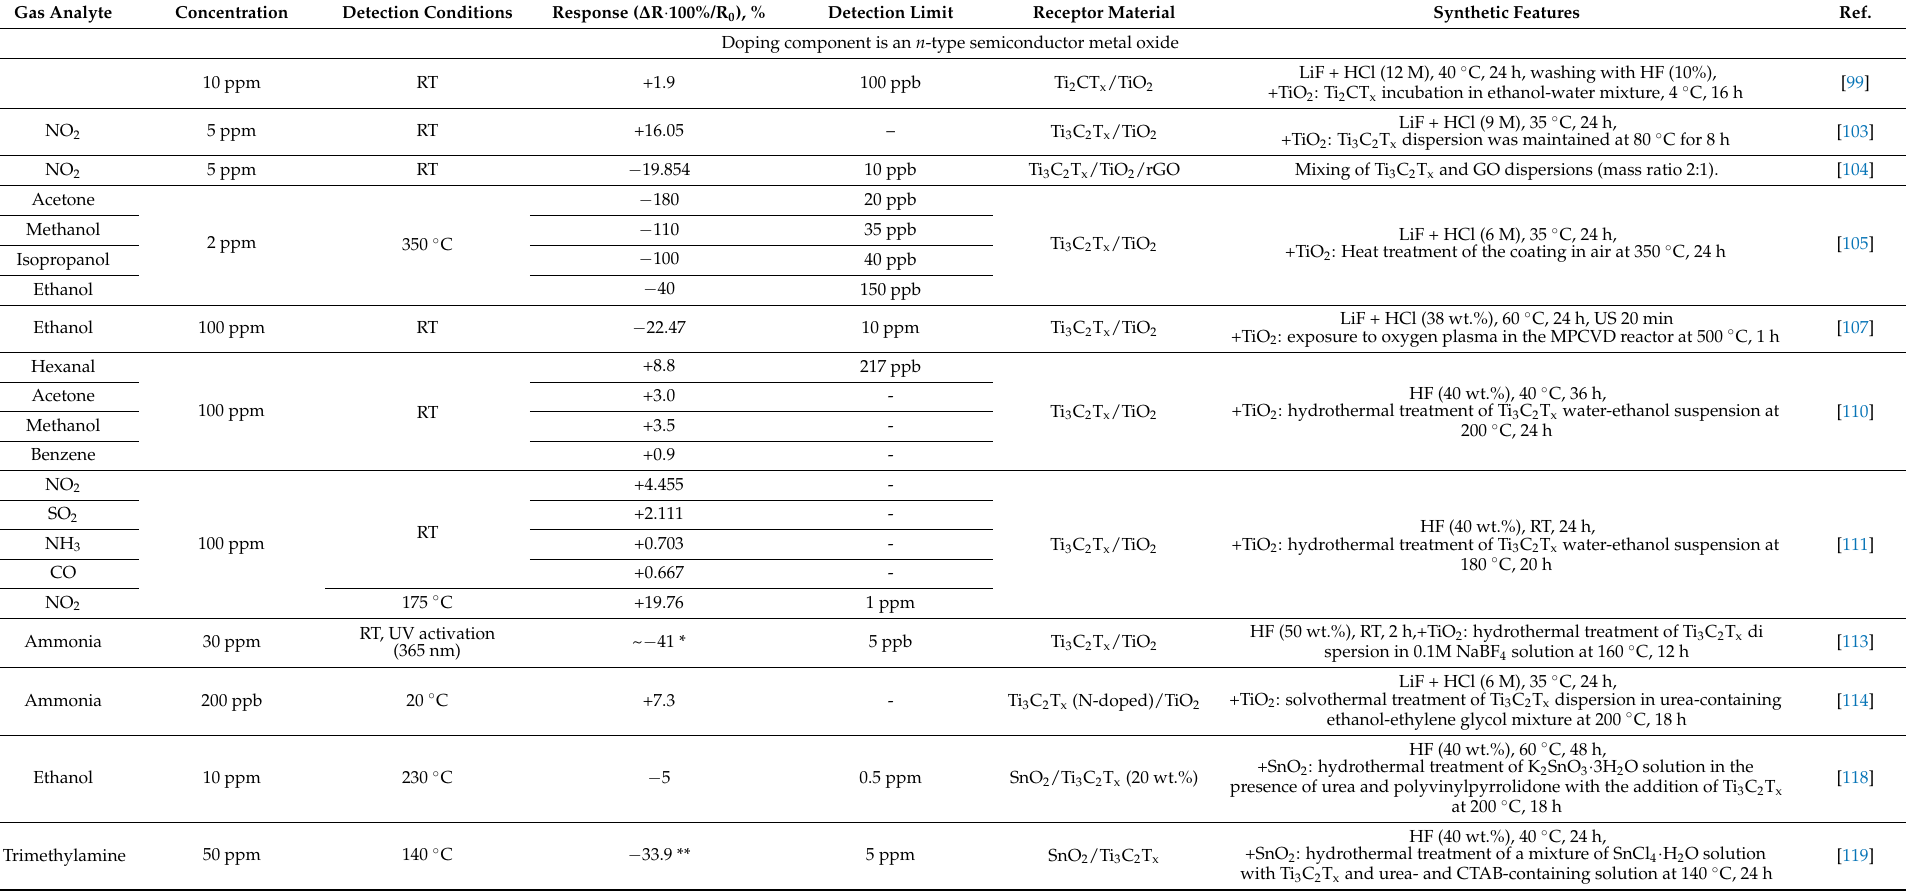
Table 2. Sensory characteristics of nanocomposite coatings containing Ti 3 C 2 T x /Ti 2 CT x MXenes and semiconducting metal